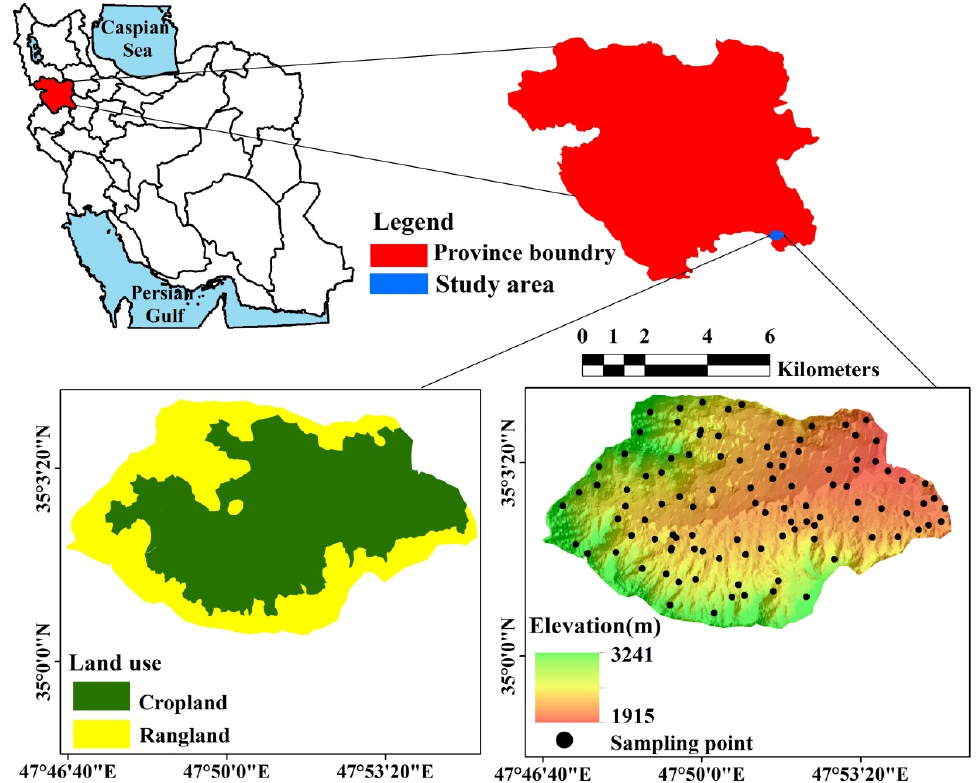
Figure 1. Location map of the study area within Kurdistan province and Iran.